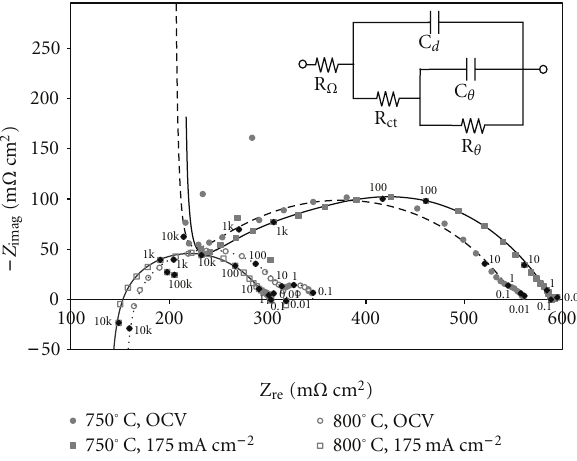
Figure 2: Nyquist plot for a button cell cathode fed with air and operating at varying temperature and load current. The data fits were obtained with the cathode equivalent circuit model in the right-hand corner of the figure. Note that a CPE is used to fit the data in place of the C d